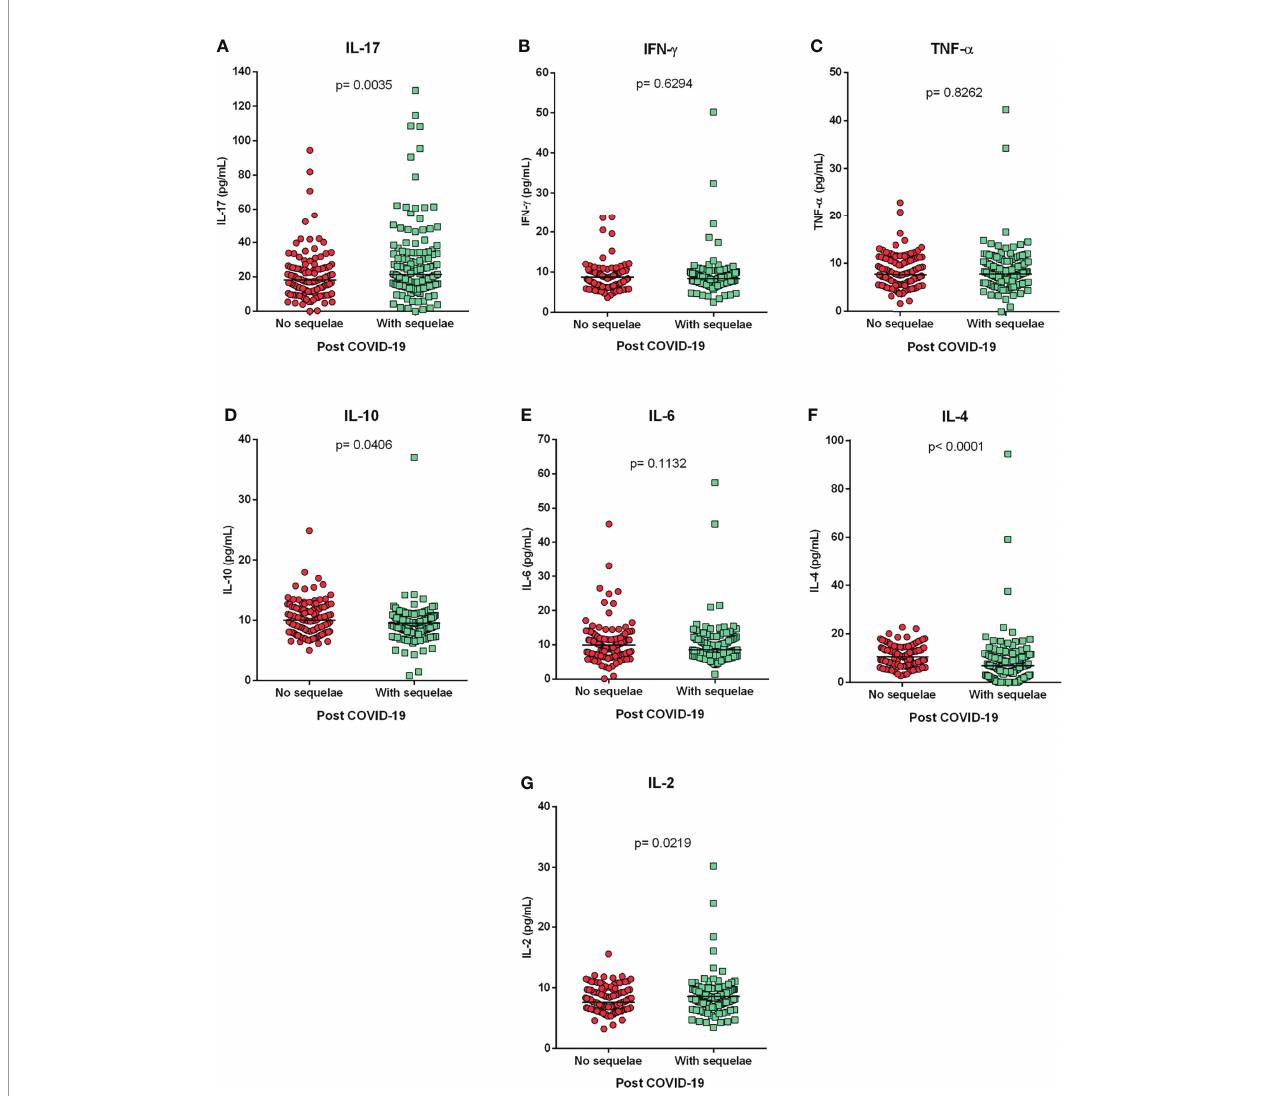
FIGURE 4 | Cytokine pro fi le in the long COVID-19. Comparison of cytokine levels (A) IL-17, (B) IFN-y, (C) TNF-a, (D) IL-10, (E) IL-6, (F) IL-4 and (G) IL-2, between individuals with and without post-COVID-19 symptoms (sequelae). Mann-Whitney